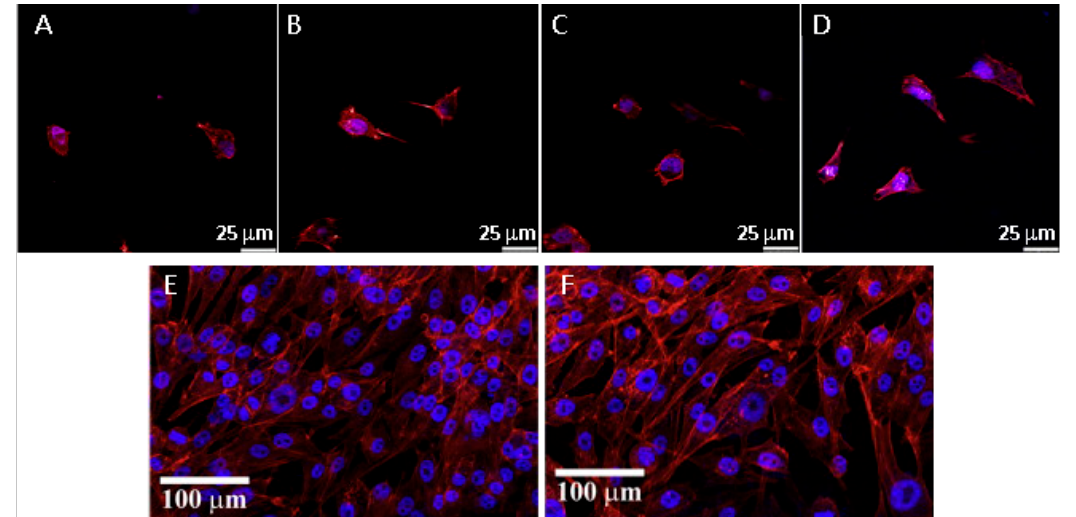
Figure 2. Fluorescence microscope images of adipose-derived mesenchymal stem cells cultured for 6 h on HAp with variable surface topography; control ( A ), nanosheet ( B ), nanorod ( C ) and micro–nanohybrid ( D ). MG63 human osteoblasts cultured for 15 days on zirconia ( E ) or alumina–zirconia particulate composites ( F ). Actin filaments are stained in red, while the cell nuclei are stained in blue. Adapted from [30,35] with permission from Elsevier.